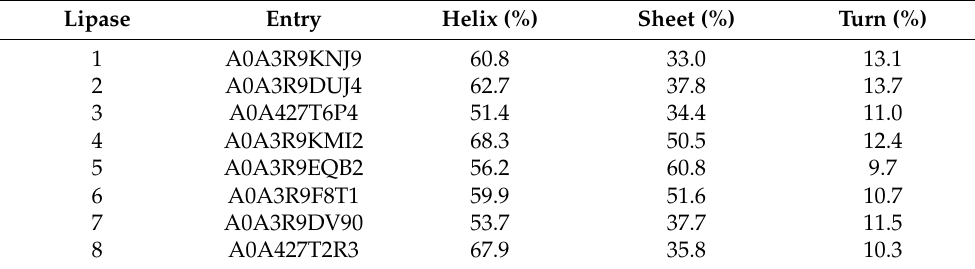
Table 5. The secondary structure of Amycolatopsis eburnea lipases